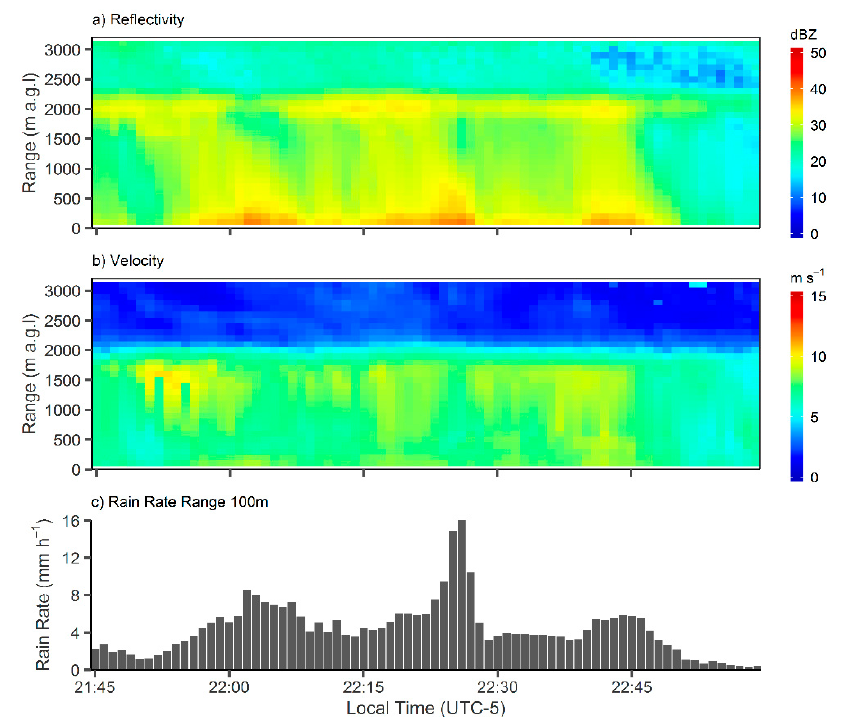
Figure 4. Event with a clear bright band on 21 March 2019: ( a ) reflectivity profile (dBZ), ( b ) vertical fall velocity (m s − 1 ), ( c ) rain rate at range of 100 m a.g.l (mm h − 1 ).